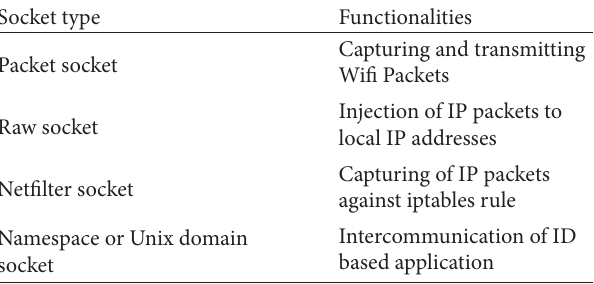
Table 3: User accessible information of network